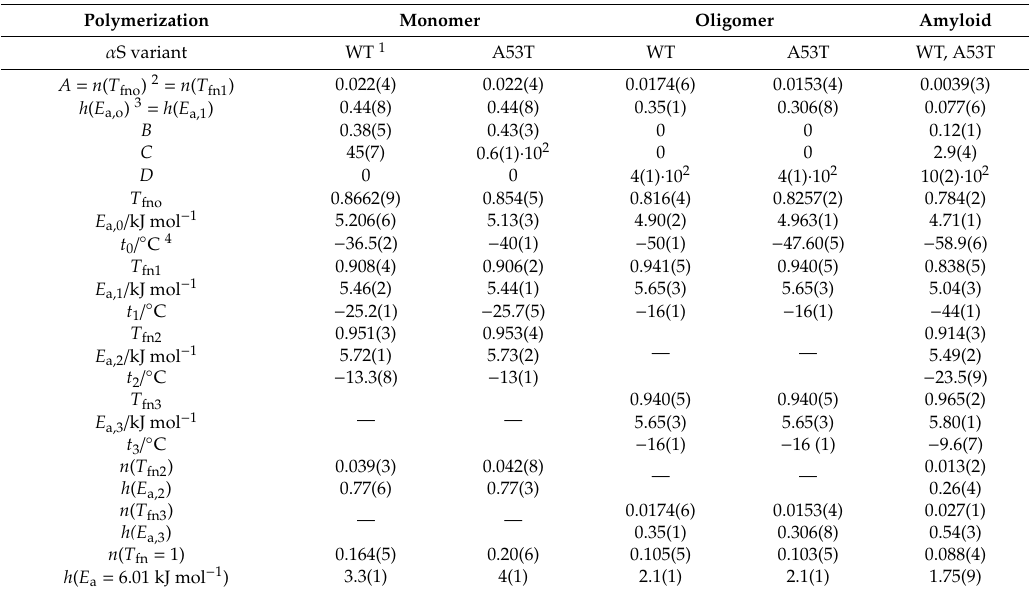
Table 1. Parameter values for the polynomial relation (Equation (2) describing mobile water fraction, n . (See Appendix A.) The error in the last digit is given in